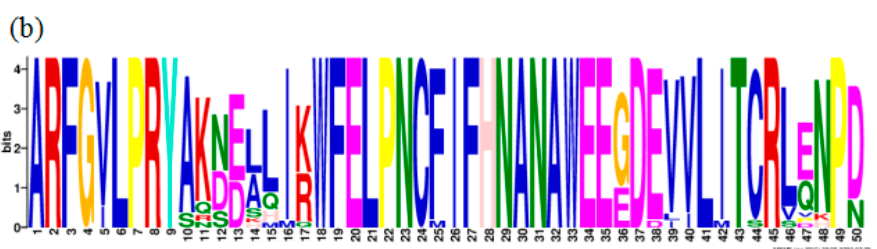
Figure 5. The conserved domains of the CCD1 amino acid sequences from a dicotyledonous plant: ( a ) conserved domains and ( b ) logo for the most conserved domain.